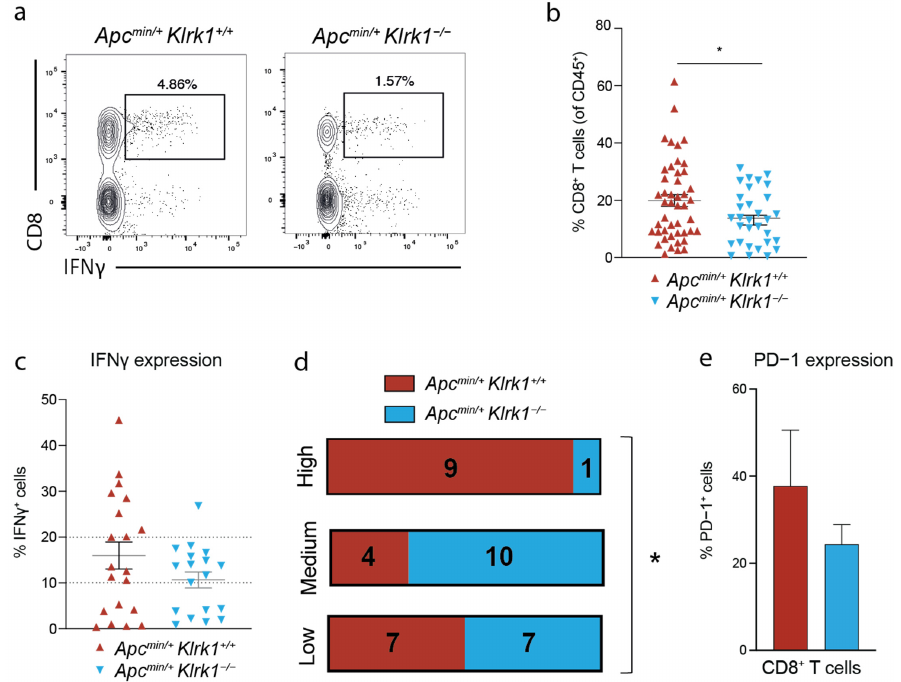
Figure 4. NKG2D deficiency leads to a reduced IFN γ response in Apc min/+ mice. ( a ) Representative flow cytometry plots of tumor-infiltrating IFN γ -producing CD8 + T cells in Apc min/+ Klrk1 +/+